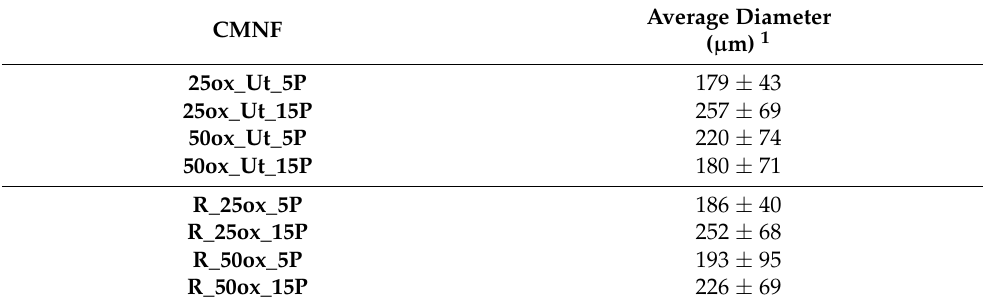
Table 4. Average diameter of CMF fraction determined by SEM.